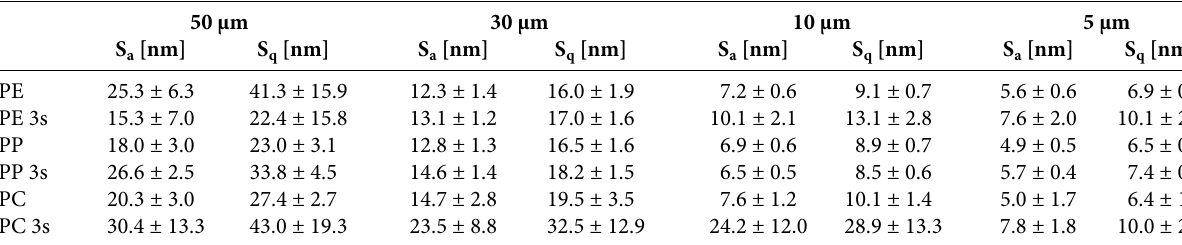
Table 2. Roughness values and their standard deviations calculated from AFM